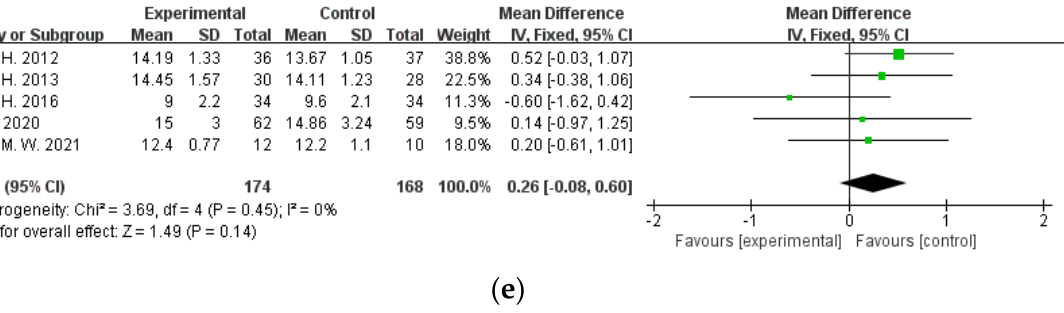
Figure 5. Forest plot of the effectiveness of exercise interventions for ( a ) muscle mass of lower ex- tremities; ( b ) skeletal muscle mass; ( c ) free fat mass; ( d ) muscle mass of upper extremities; and ( e ) appendicular muscle mass improvement in older adults with sarcopenia.